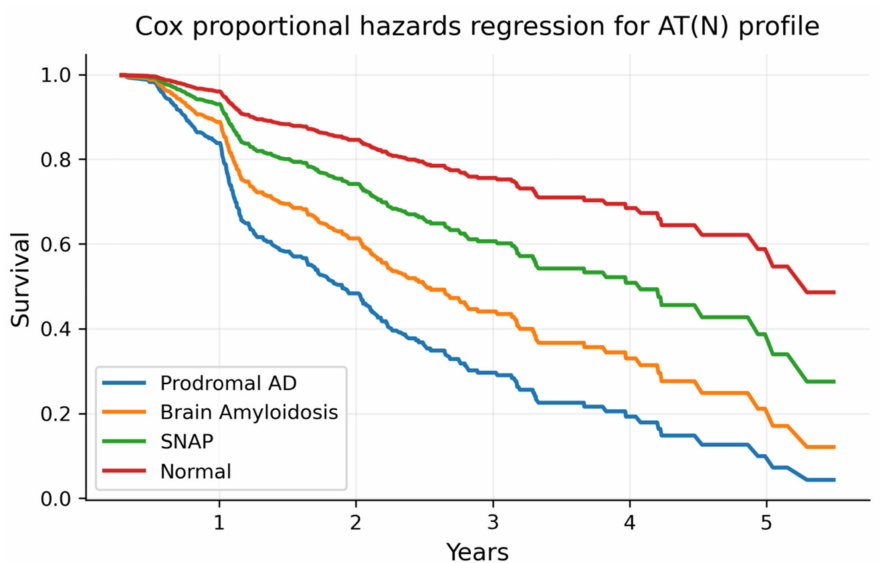
Figure 1. Survival curves of conversion to dementia for each AT(N) profile. Note: survival curves of conversion to dementia for each AT(N) profile obtained in the model presented in Table 5. AD: Alzheimer’s Disease; SNAP: Suspected Non-Alzheimer’s Pathology.